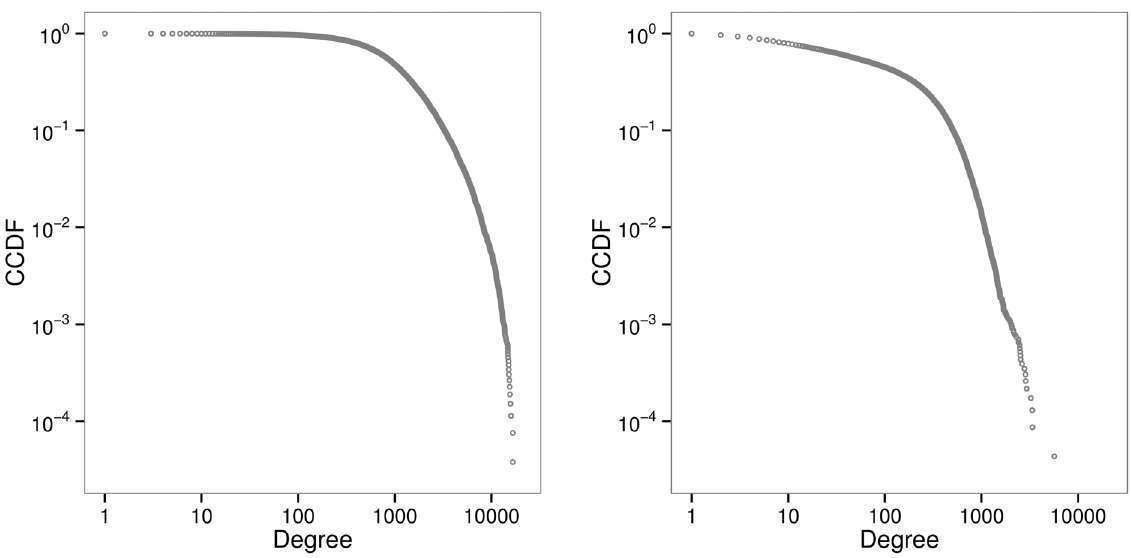
Figure 2. Complementary cumulative degree distribution. The plot shows degree distribution for full (left figure) and major (right figure) MeSH networks.